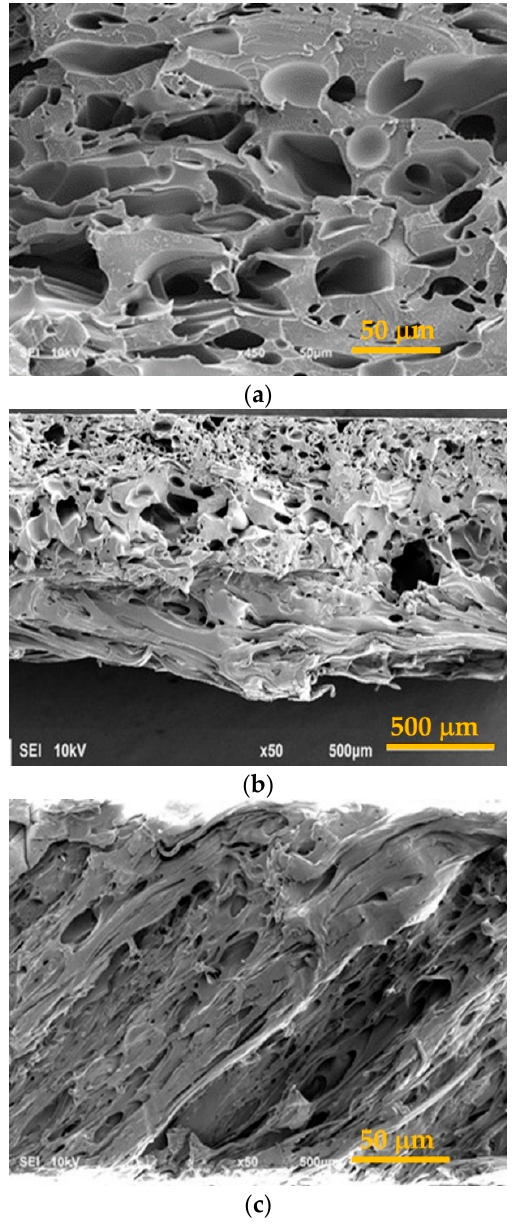
Figure 10. SEM image of PETG foam structure of a sample with different densities: ( a )—124 kg/m 3 , ( b )—325 kg/m 3 , ( c )—650 kg/m 3 .